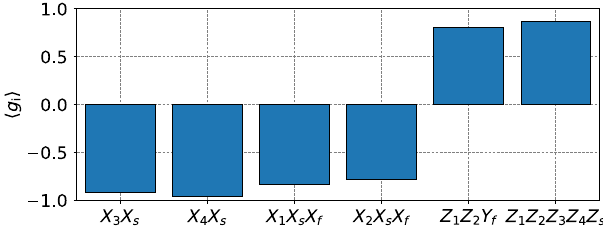
FIG. 10. Expectation values of stabilizer generators g for verification of six-qubit GME. Each X -type stabilizer is evaluated from 500 shots, while the Z -type stabilizers are evaluated from 1000 shots each. The average shot-noise errors are about 2 × 10 − 2 for all stabilizer expectation